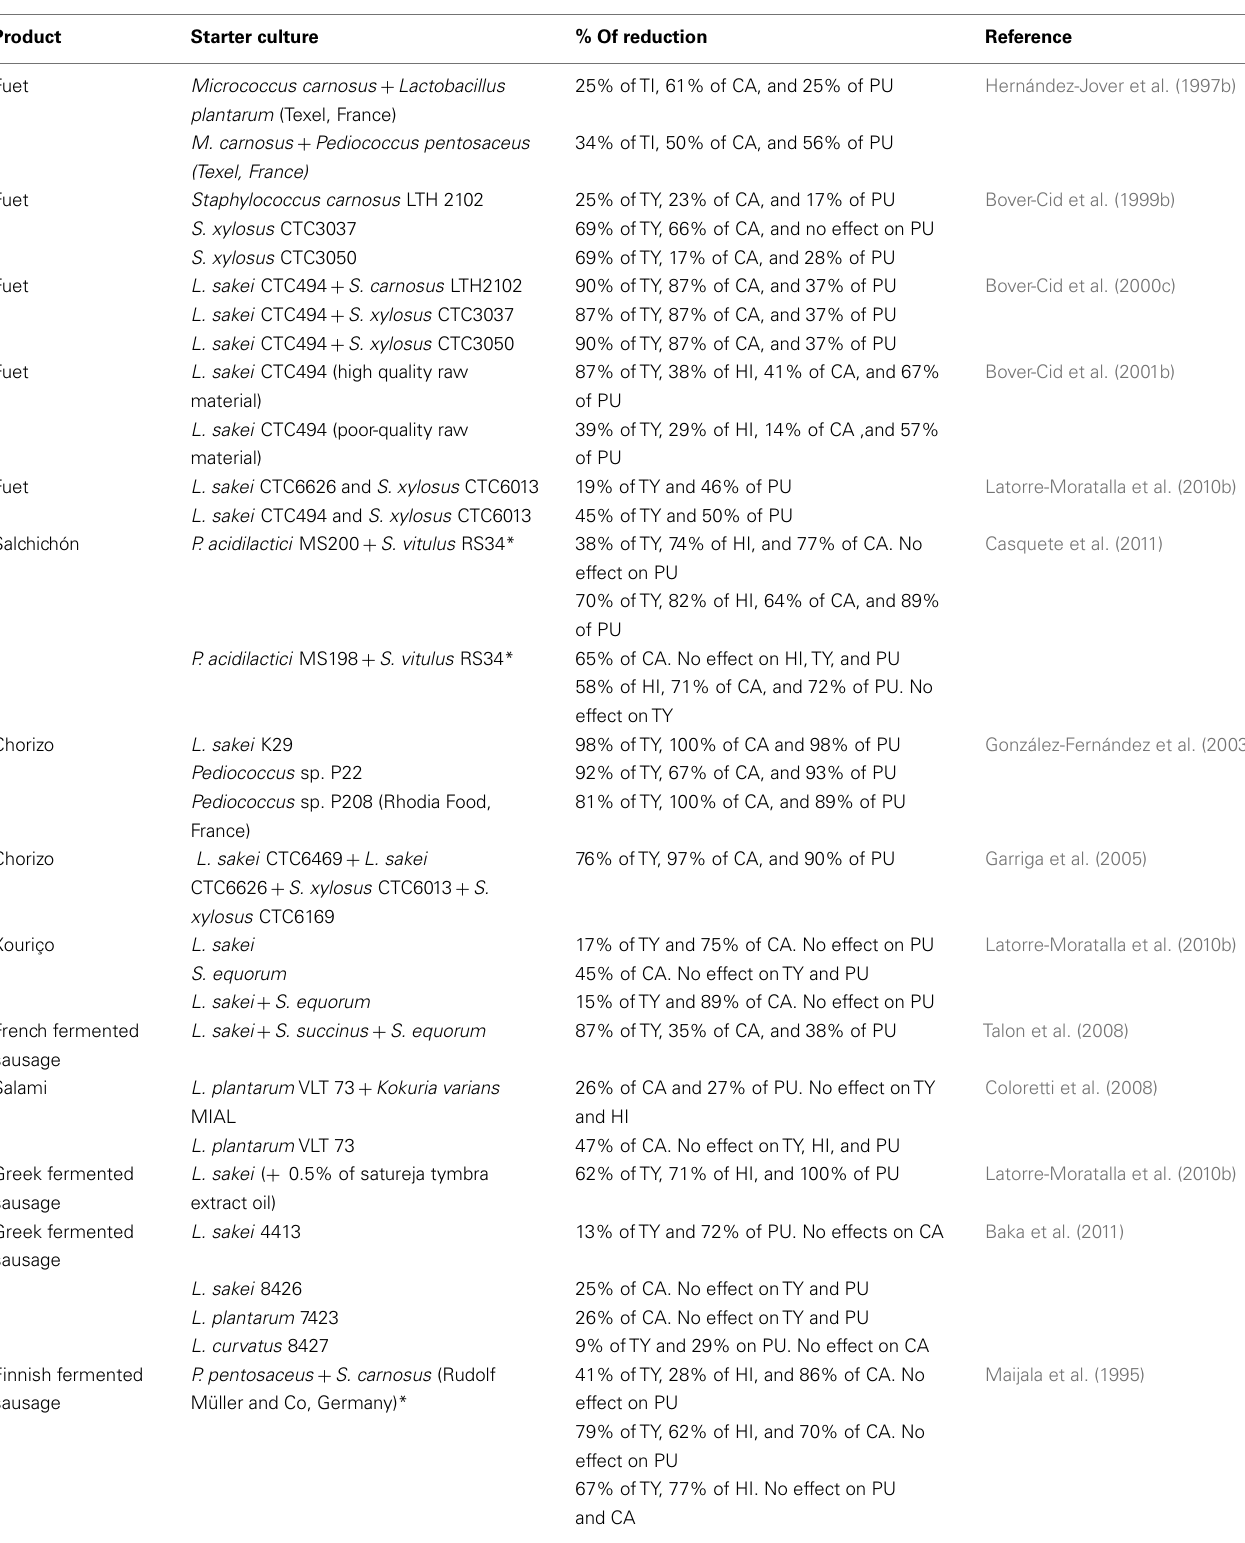
Table 2 | Different studies on the effect of amine-negative starter cultures on biogenic amine reduction during the manufacture of fermented